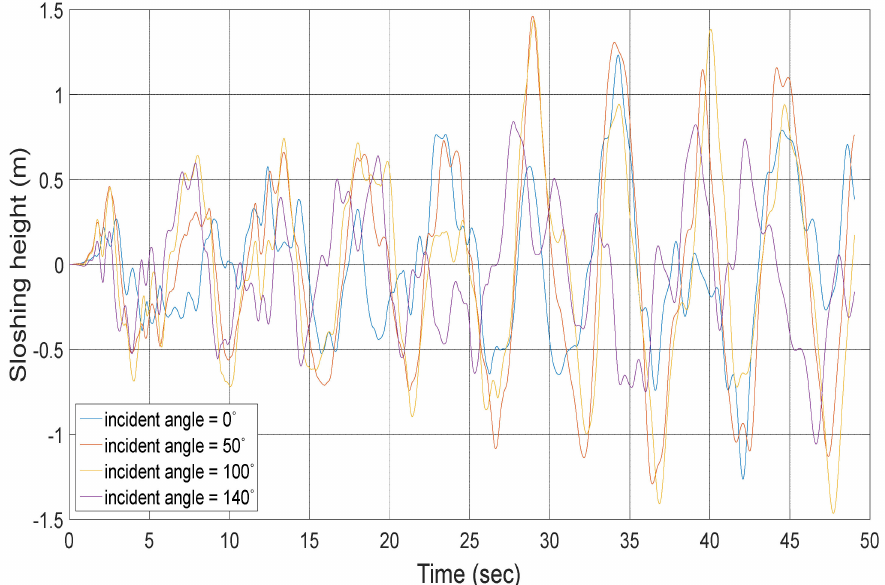
Figure 19. Sloshing heights at the free